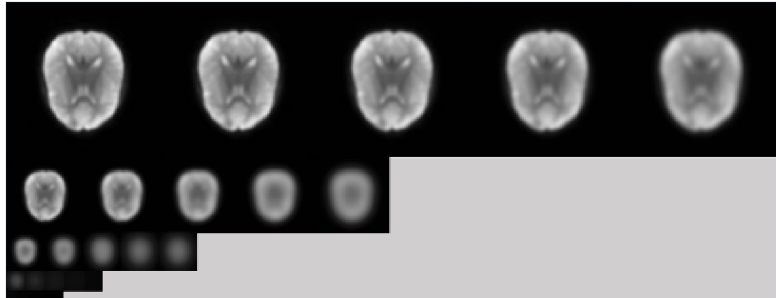
Figure 2. An example of Gauss pyramid.